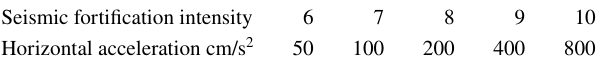
Table 1 Seismic intensity distribution parameters Seismic Shape fac- fortification tor K intensity I 0